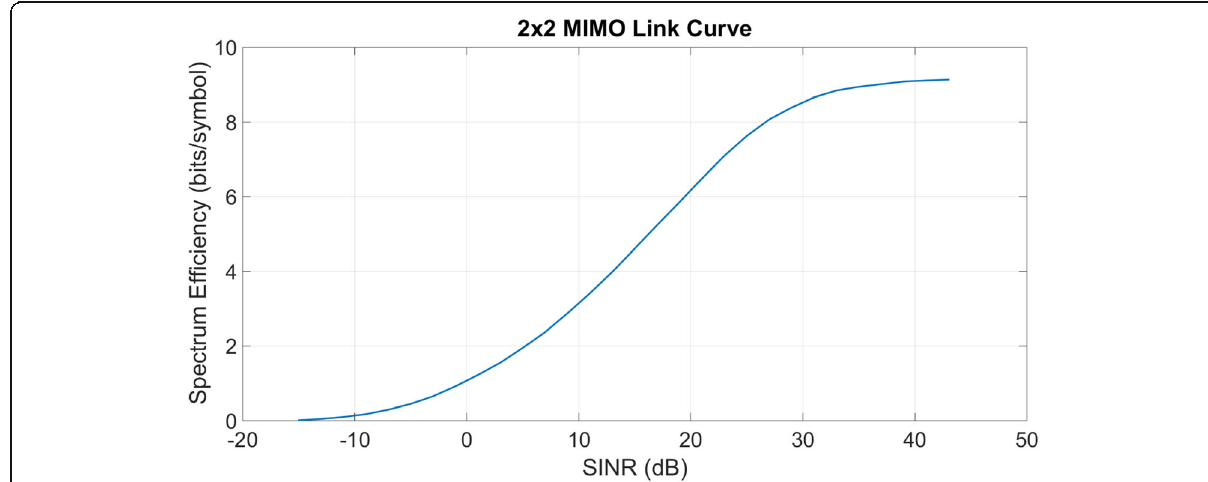
Fig. 7 2 × 2 MIMO link